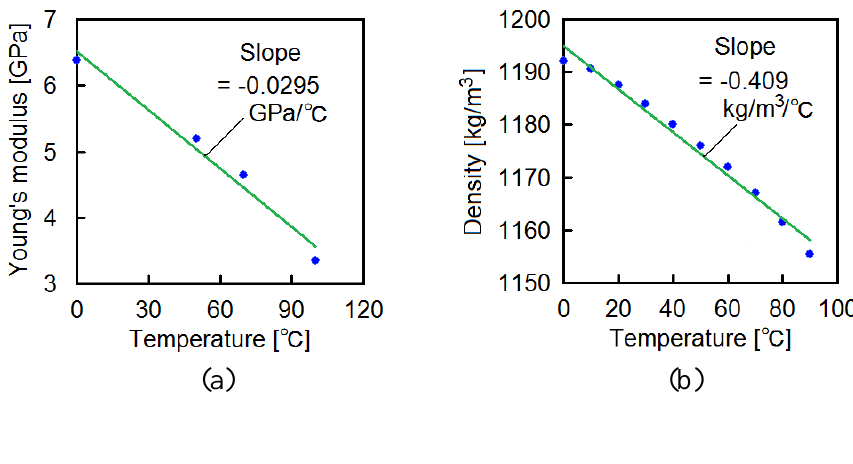
Figure 8. (a) Young’s modulus of bulk PMMA vs. temperature. (b) Density of bulk PMMA vs. temperature (plotted using the data reported in